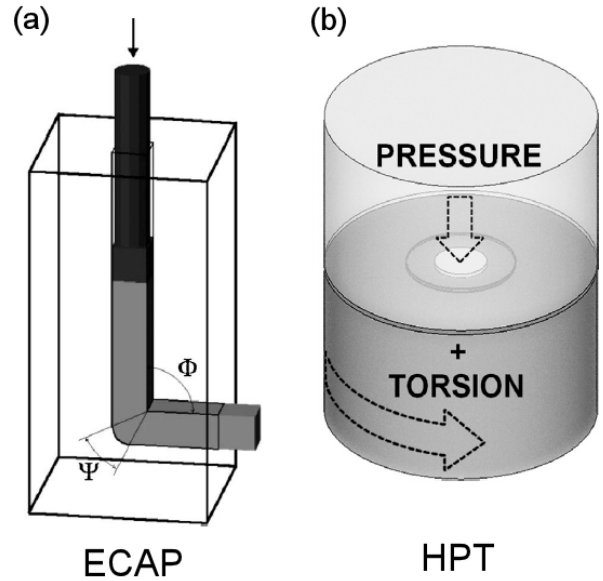
Figure 2. Illustration of the principles of ( a ) ECAP [20] and ( b ) HPT [21].